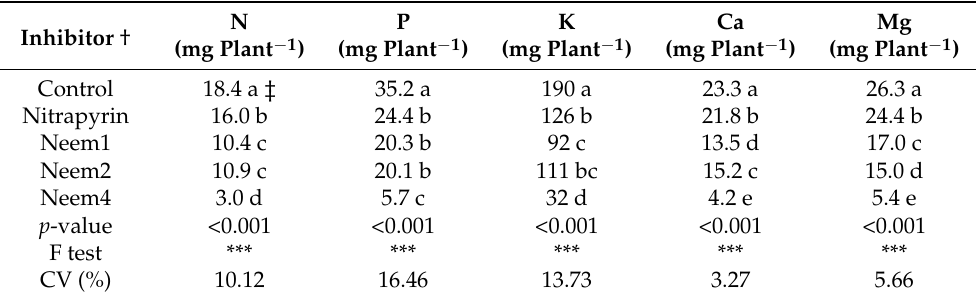
Table 5. Macronutrient uptakes of lettuce as affected by different nitrification